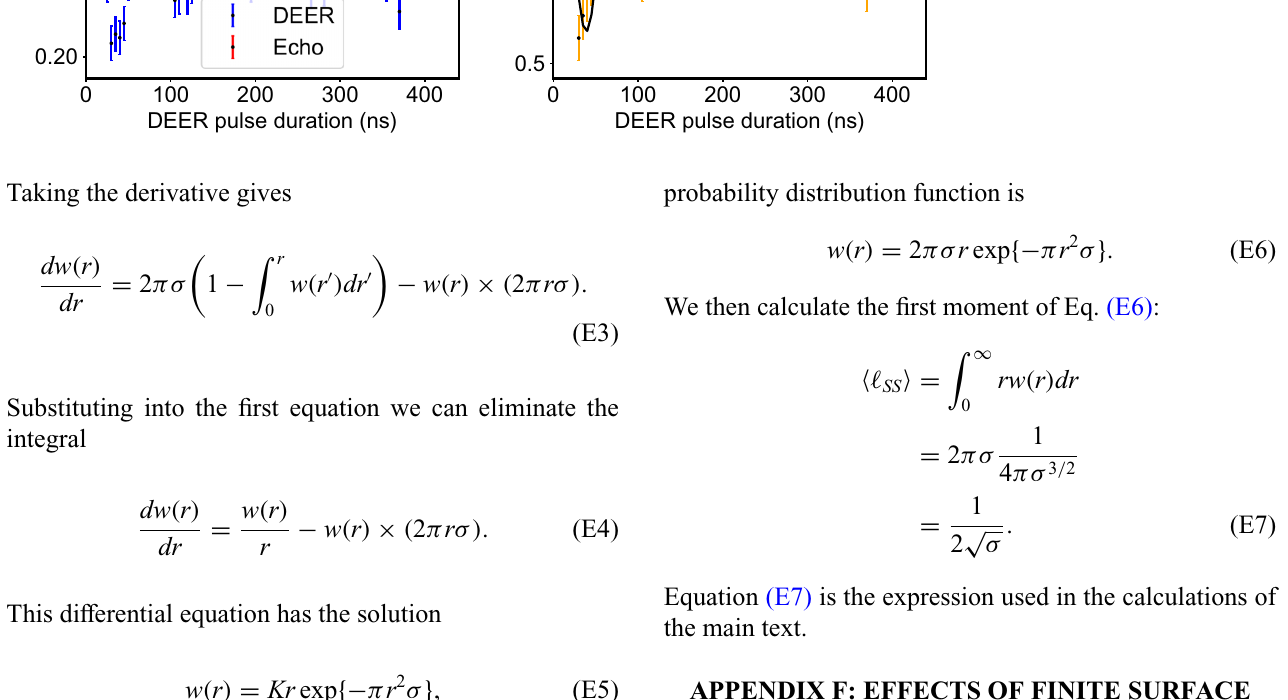
FIG. 12. Measured T 1 of sur- face spins using a correla- tion sequence. Relaxation time T 1 for surface spins measured by two different NV centers, depicted in (a) and (b), using the correlation sequence described in Ref.